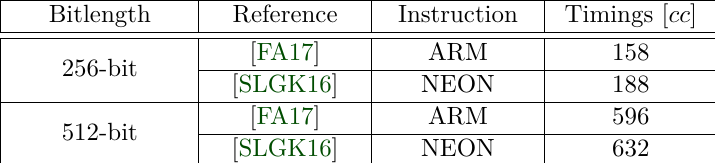
Table 1: Comparison of 256-bit and 512-bit multiprecision multiplications using non- redundant representations and implemented with either ARM or NEON instructions (32-bit ARMv7-A architecture). The results (in clock cycles) were obtained on an ARM Cortex-A15 processor.